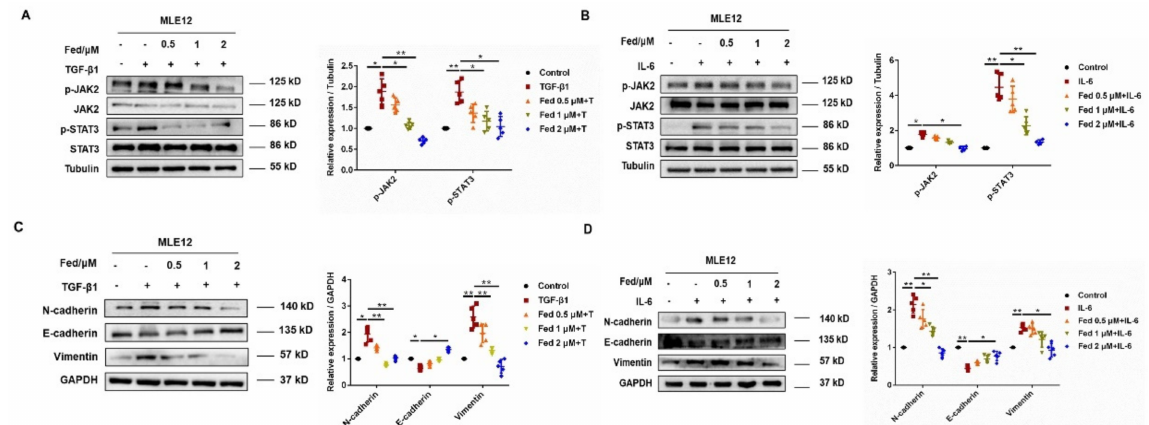
Figure 1. Fedratinib inhibits mesenchymal marker expression in epithelial cells through inhibiting JAK2/STAT3 signaling. ( A , B ) Ratios of JAK2/p-JAK2 and STAT3/p-STAT3 were determined by Western blotting in MLE12 cells stimulated for 24 h with TGF- β 1 (5 ng/mL) or IL-6 (50 ng/mL) at different concentrations of fedratinib. ( C , D ) MLE12 cells were treated with TGF- β 1 or IL-6 and Fed (0.5, 1 and 2 µ M) for 24 h. Protein expression levels of E-cadherin, vimentin and N-cadherin were assessed by Western blot. GAPDH was used as a loading control in grayscale analysis. Data are presented as the means ± SD ( n = 5). Comparisons between groups were achieved using one-way analysis of variance (ANOVA). * p < 0.05, ** p < 0.01.